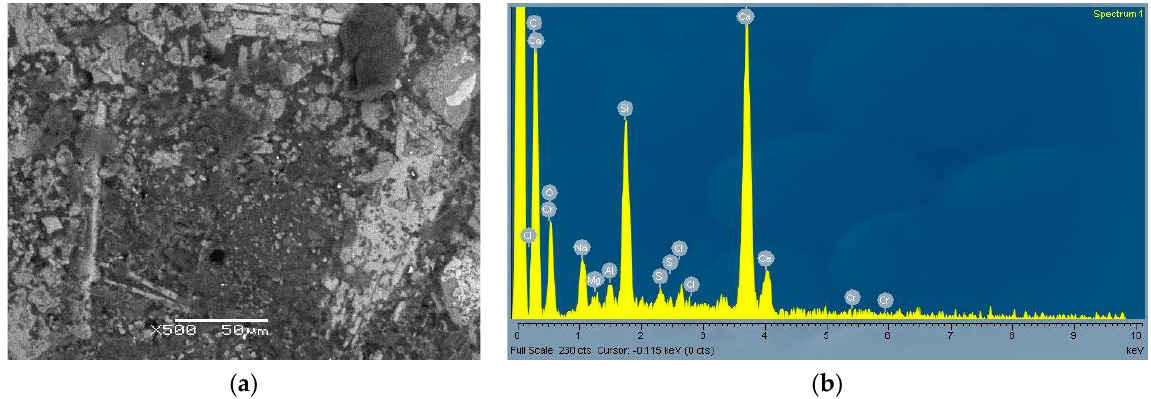
Figure 7. SEM image of CWA paste—darker area from Figure 6a ( a ) with corresponding EDS ( b ).